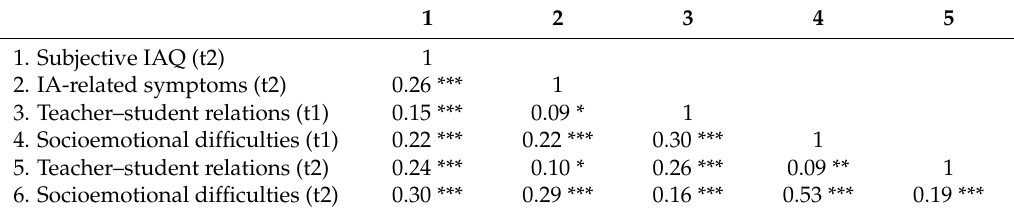
Table 2. Bivariate correlation coefficients of outcome variables (1–2) and psychosocial predictors (3–6). 1 2 3 4